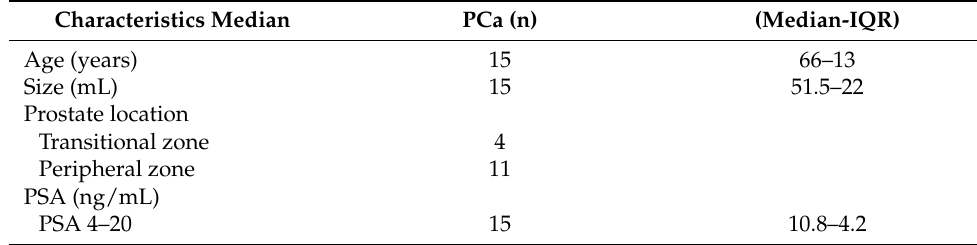
Table 1. Patient characteristics. Characteristics Median